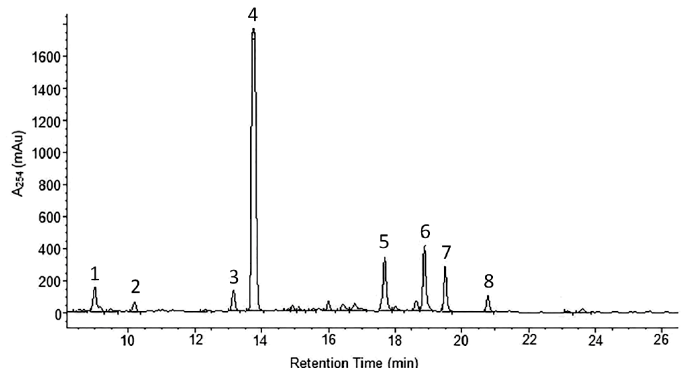
Figure 4. The selected segment of HPLC-DAD chromatogram of the chloroform fraction (CF) recorded at 254 nm. Peak assignments (tentative identification): 1. unknown; 2. ferulic acid; 3. 1 β ,10 β - epoxydesacetoxymatricarin (CP1); 4. leucodin (CP2); 5. 5-demethylsinensetin (CP3); 6. 2-(3,4-dimethoxy- phenyl)-3-hydroxy-5,6,7-trimethoxy-chromen-4-one (CP4); 7. salvigenin (CP5); 8. unknown.